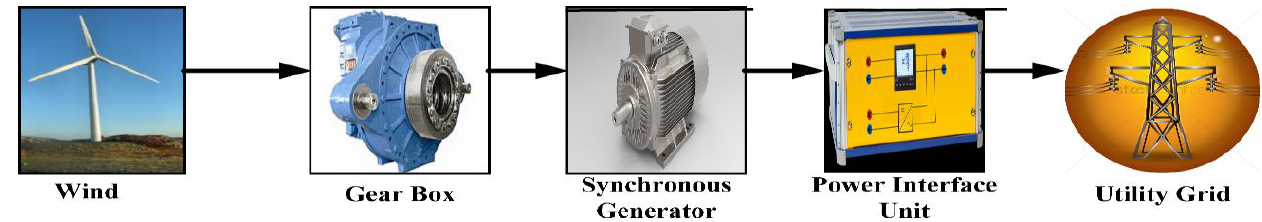
Figure 4. Basic wind energy system with the utility grid [36].